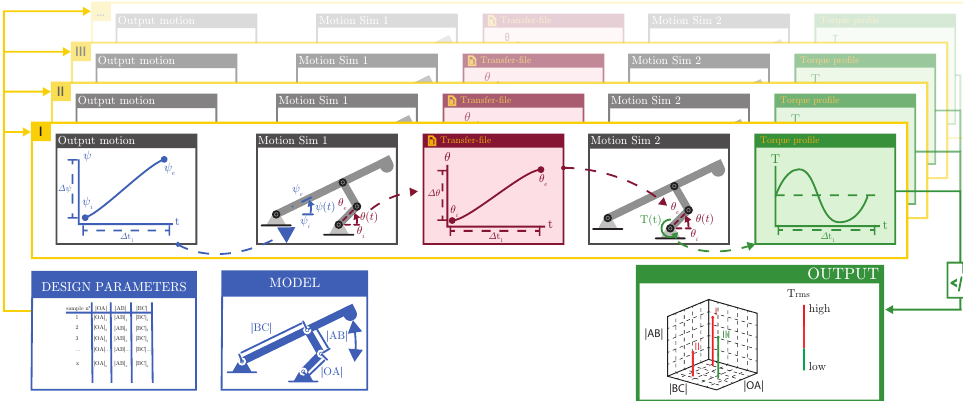
Figure 5. This approach performs the necessary driving torque calculation of the mechanism.